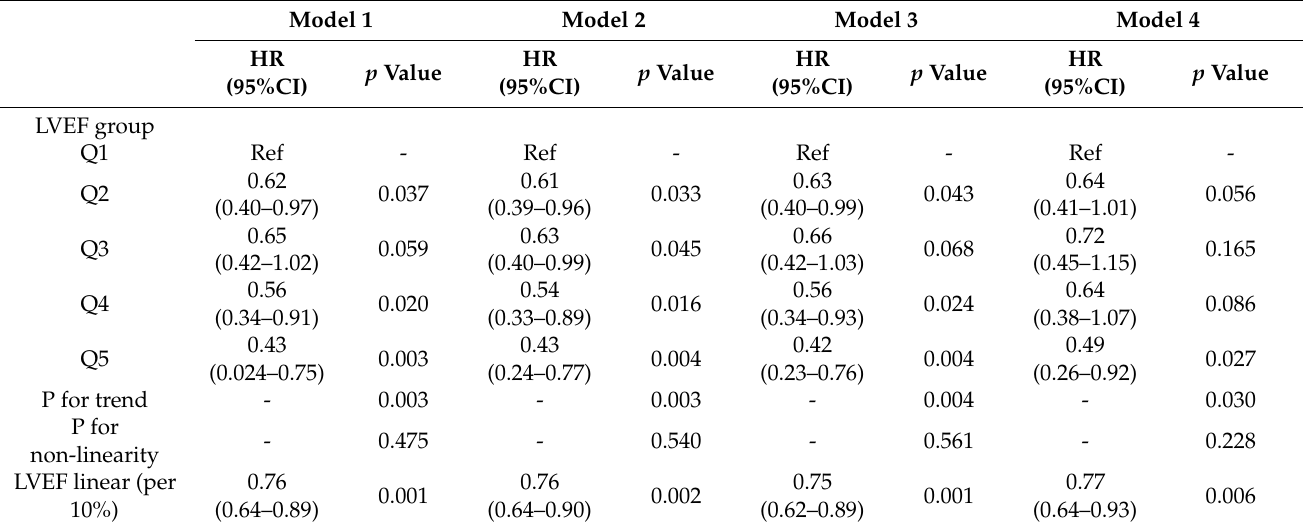
Table 2. Results of multivariable Cox regression for all-cause mortality by LVEF quintiles.